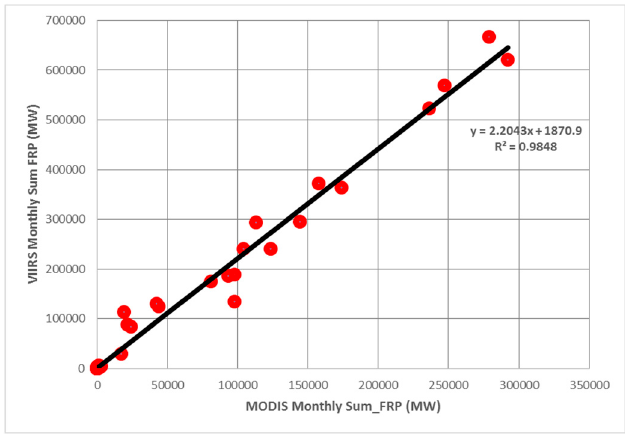
Figure 6. Correlation between MODIS Sum of FRP and VIIRS Sum of FRP, Punjab, India.